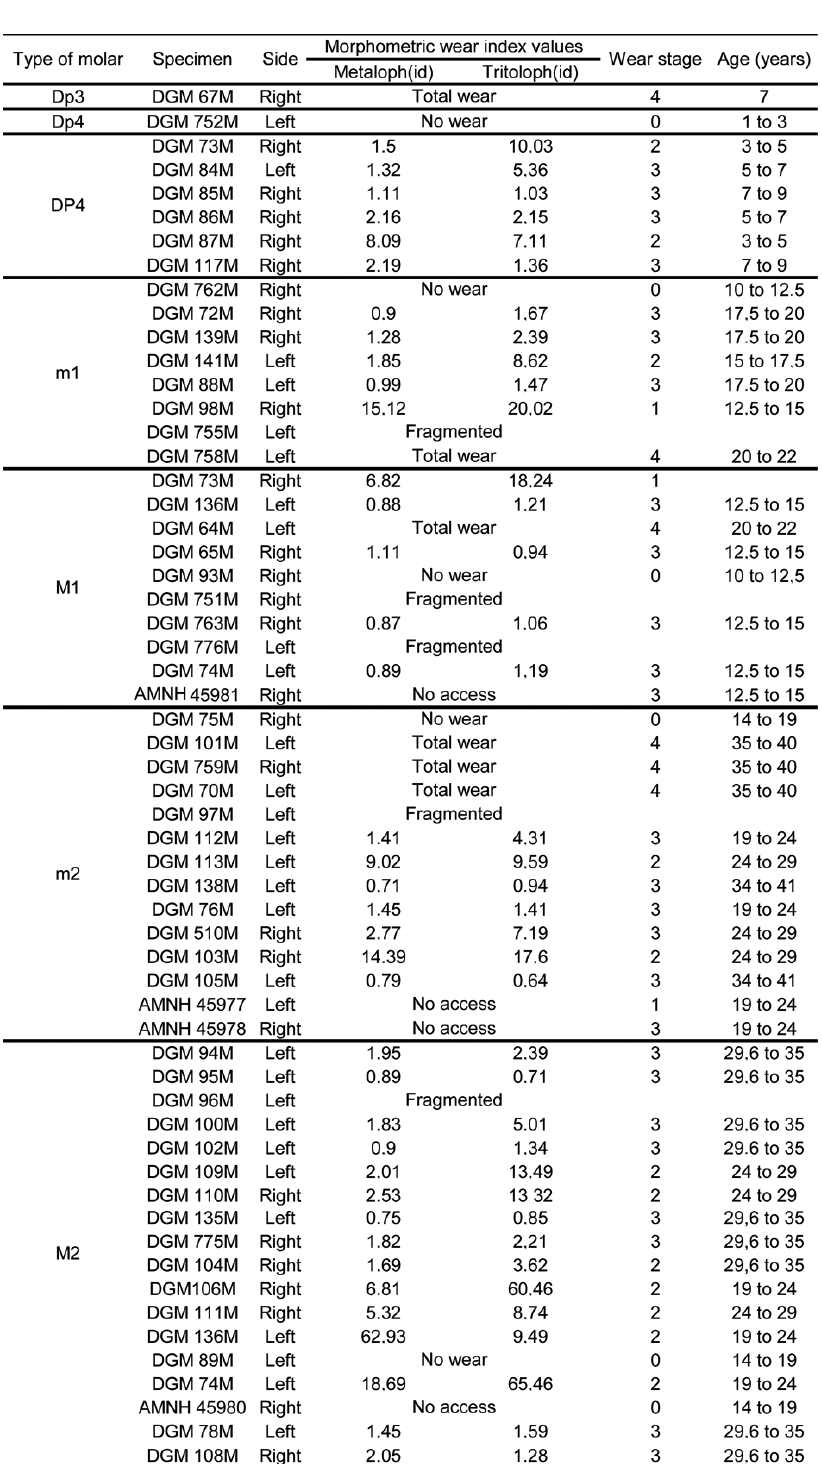
Fig. 5–IntermediategroupofdentaryspecimensassignedbySimpsonandPaula-Couto(1957) and reviewed here by our proposed morphometric index. The specimens with “No access” correspond to those in situ and those housed at the American Museum of Natural History (New York, USA), in situ and at the Universidade Federal de Minas Gerais (Minas Gerais,